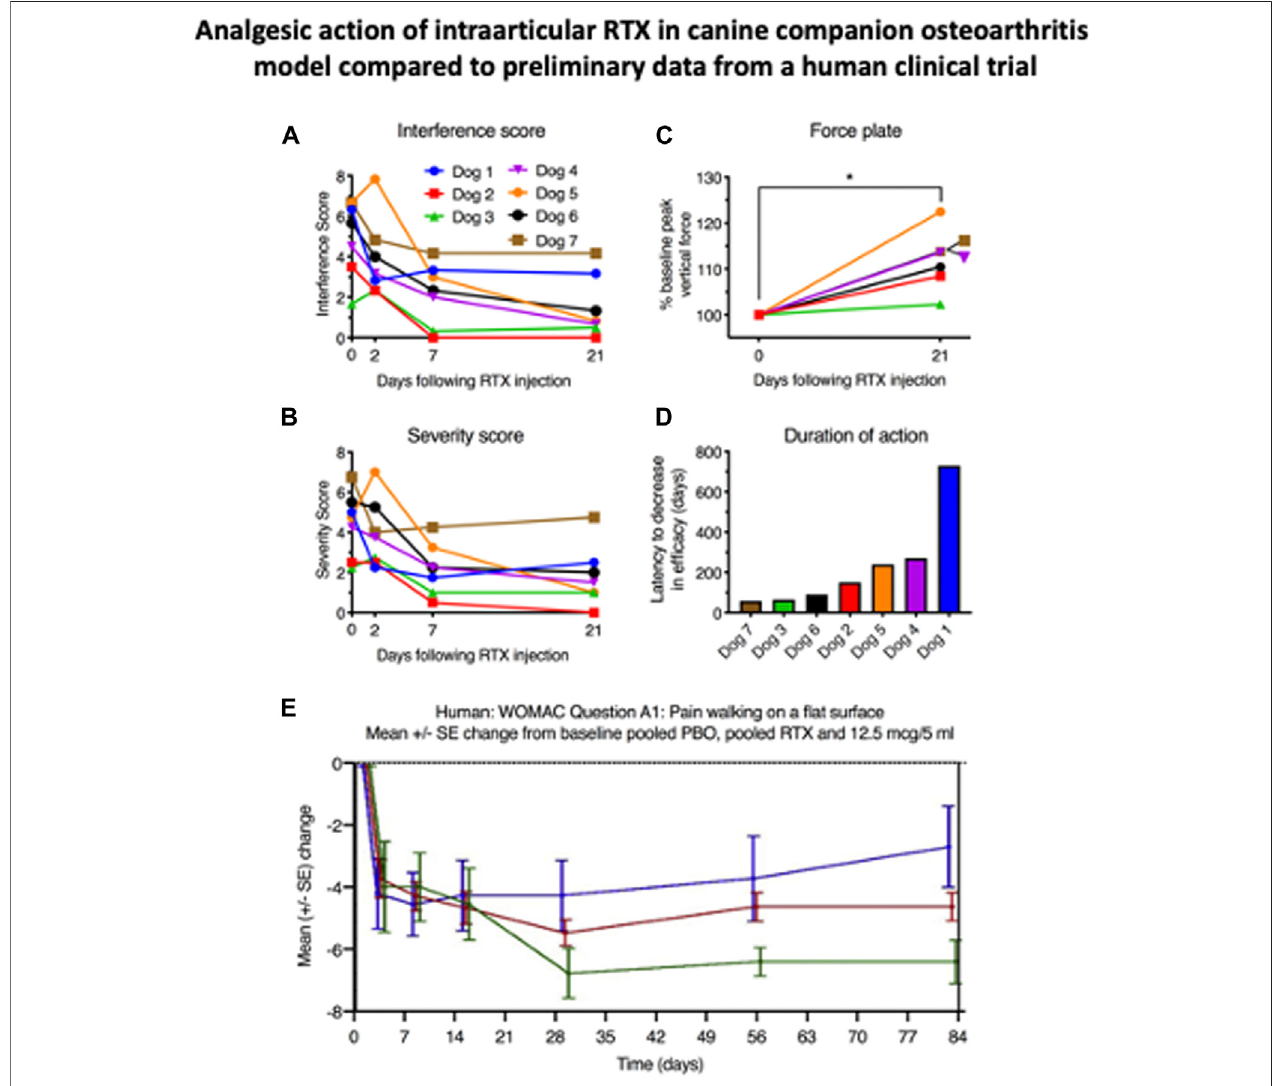
FIGURE 4 | Analgesic action of intraarticular RTX in companion canine osteoarthritis model compared to preliminary data from a human clinical trial. These fi ve panels show the fl uid transition from the companion canine model to a human osteoarthritis clinical trial. In both species RTX was delivered intraarticularly (fore or hind limb in the dog and into the knee joint in the human). The canine work is from reference 37, the human clinical data are adapted from a published abstract (Leiman et al., 2020). Note the duration of the 5 ml placebo injection which only begins to wane after 14 days despite the fact that only one injection of either vehicle or RTX was delivered reducing the opportunities for reinforcement such as daily oral medication which are absent with this interventional single injection treatment.